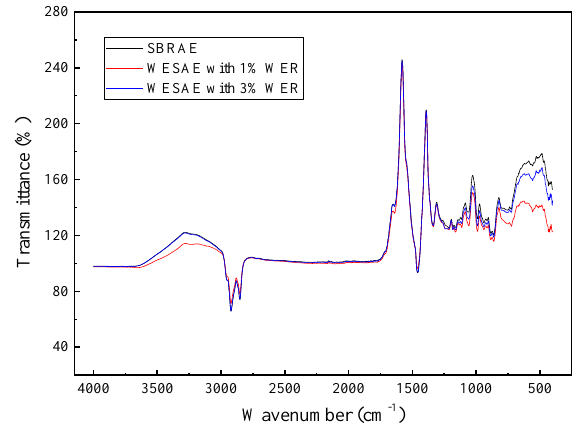
Figure 9. Infrared spectra for WESAE with 1% and 3% WER and for SBRAE.